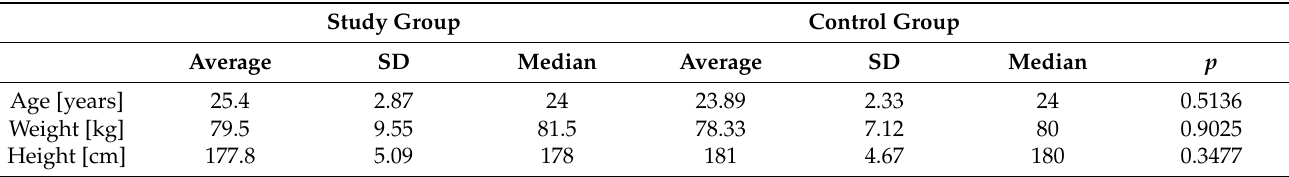
Table 1. Characteristics of the tested groups.